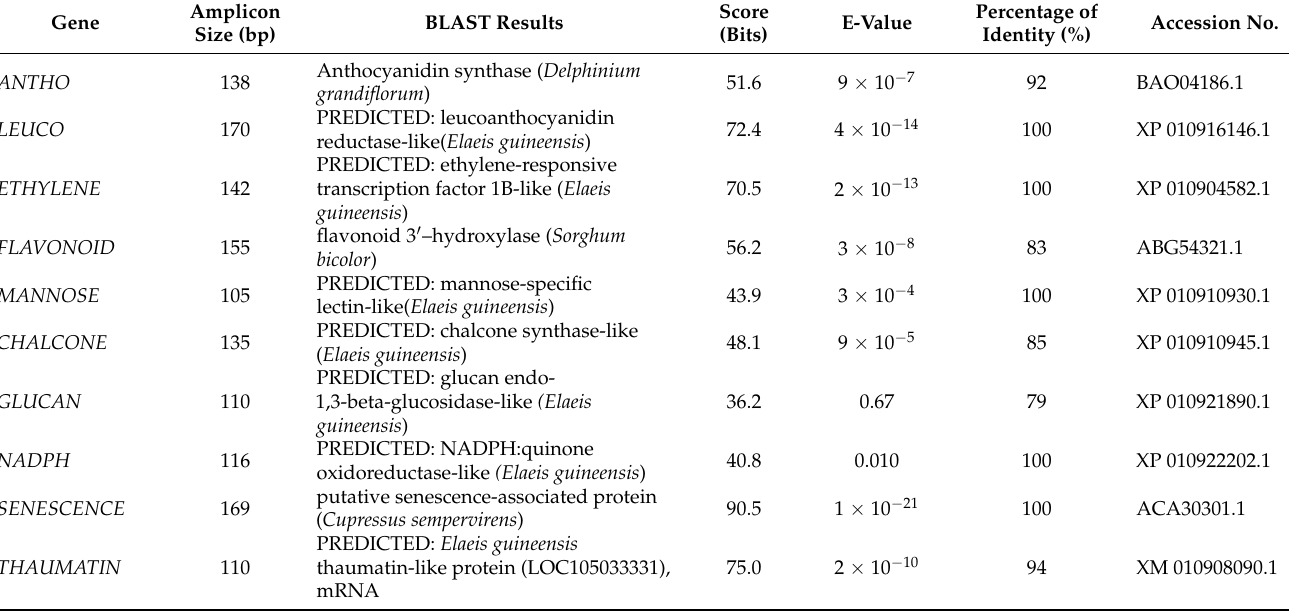
Table 4. BLASTX of genes of interest for oil palm root against the oil palm genome